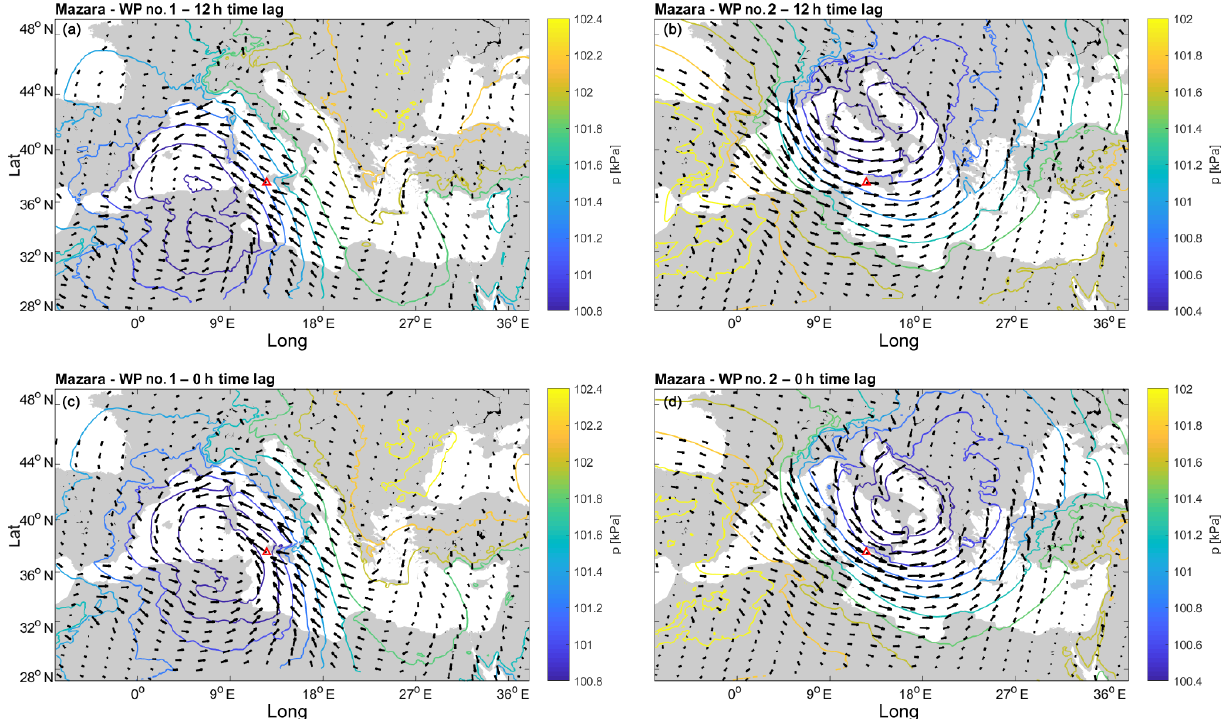
Figure 3. Average MSLP for the H s peaks in Mazara del Vallo (B4). (a) WP#1, (cid:49)t equals 12h; (b) WP#2, (cid:49)t equals 12h; (c) WP#1, (cid:49)t equals 0h; and (d) WP#2, (cid:49)t equals 0h.